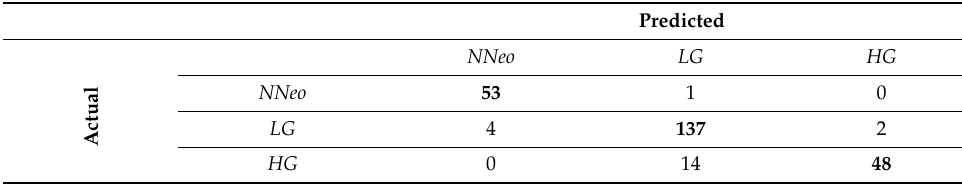
Table 3. Confusion matrix of the MLP (75;5) in the multiclass setup, using the CRC test set (259 samples), with non-neoplastic (NNeo), low-grade (LG) and high-grade (HG) classes. In bold are the best results per column.